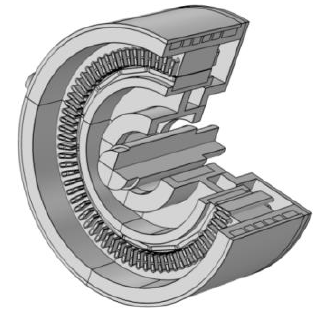
Figure 11. Schematic diagram of three-field coupling